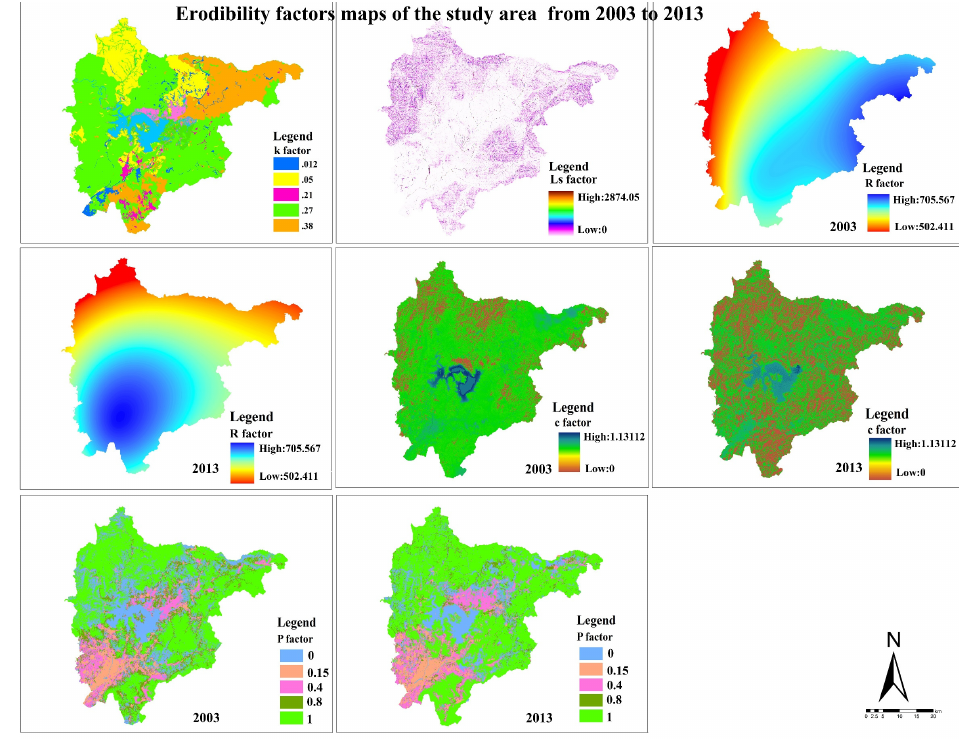
Figure 2. Erodibility factor maps of the RUSLE model in different periods.